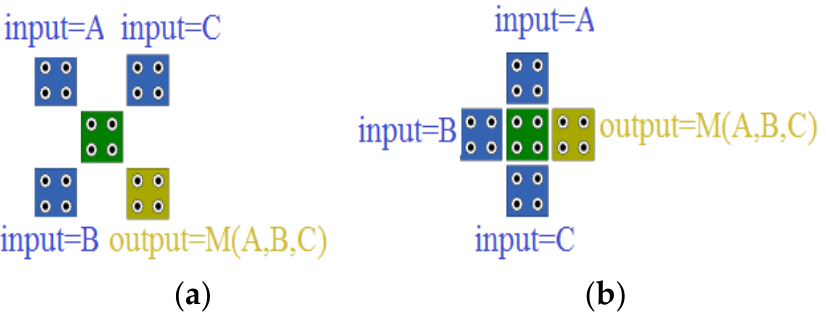
Figure 3. ( a ) Inverted MV gate, and ( b ) Regular MV gate.